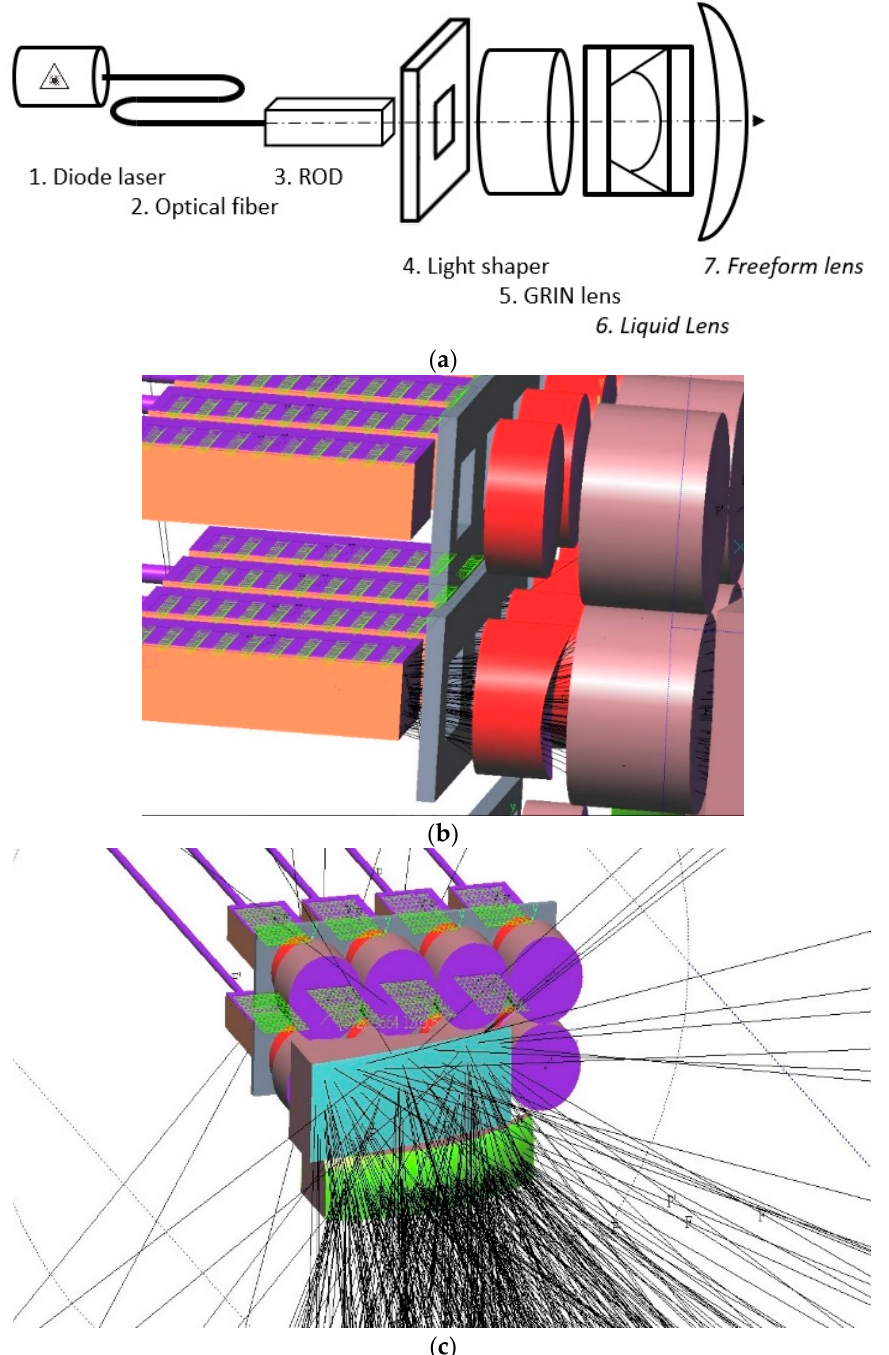
Figure 2. ( a ) Schematic of the laser automotive headlight system. ( b ) Simulation and ray tracking of ROD (orange), GRIN lens (red) and liquid lens (brown) via LightTools under the education license of ORA, U.S.A; ( c ) simulation and ray tracking of whole system including fiber, ROD, GRIN lens (red), liquid lens (brown), freeform for low beam (green) and high beam (blue).